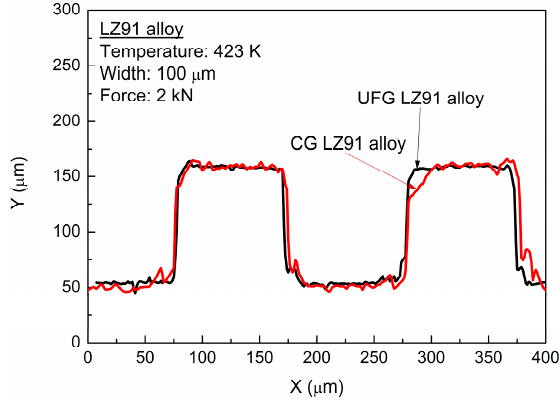
Figure 10. Comparison of the filling quality using CG and UFG Mg-Li alloy.